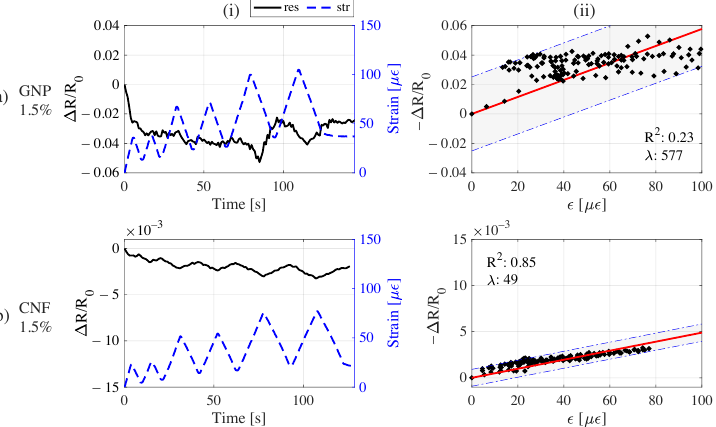
Figure 8. Strain and fractional variation of resistance time histories ( i ) and linear fit models of sensing ( ii ) of a sample with GNPs ( a ) and a sample with CNFs ( b ).